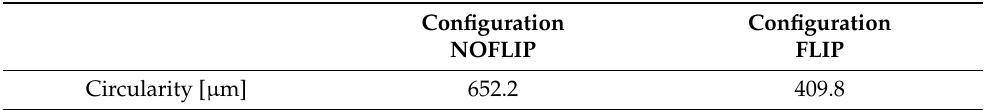
Figure 10. Polar graphs from measuring a circle on the inclined plane. ( a ) NOFLIP configuration; ( b ) FLIP configuration. Table 5. Average circularity value for both robot arm